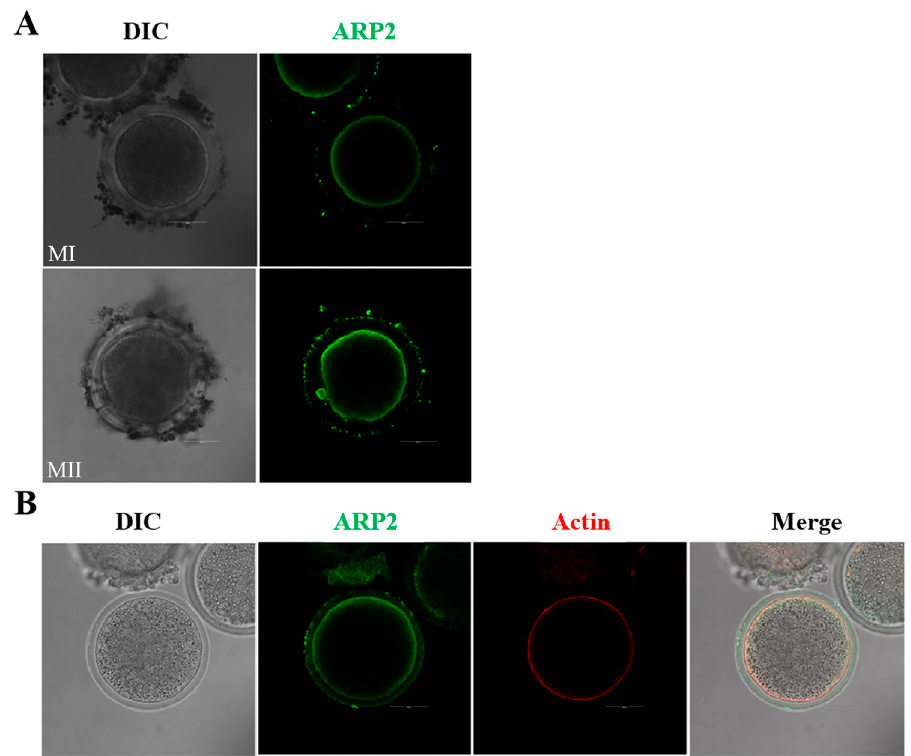
Figure 2. Localization of Arp2 in goat oocytes. ( A ) The subcellular localization of Arp2 in goat oocytes at MI and MII stages. Arp2 was found in greater abundance at the cortex. Green, Arp2-antibody. Bar = 50 µ m. ( B ) Co-staining of oocytes for Arp2 and F-actin. Arp2 was present in the cortical region and was overlapping with F-actin. Green, Arp2-antibody; Red, F-actin. Bar = 50 μ m.